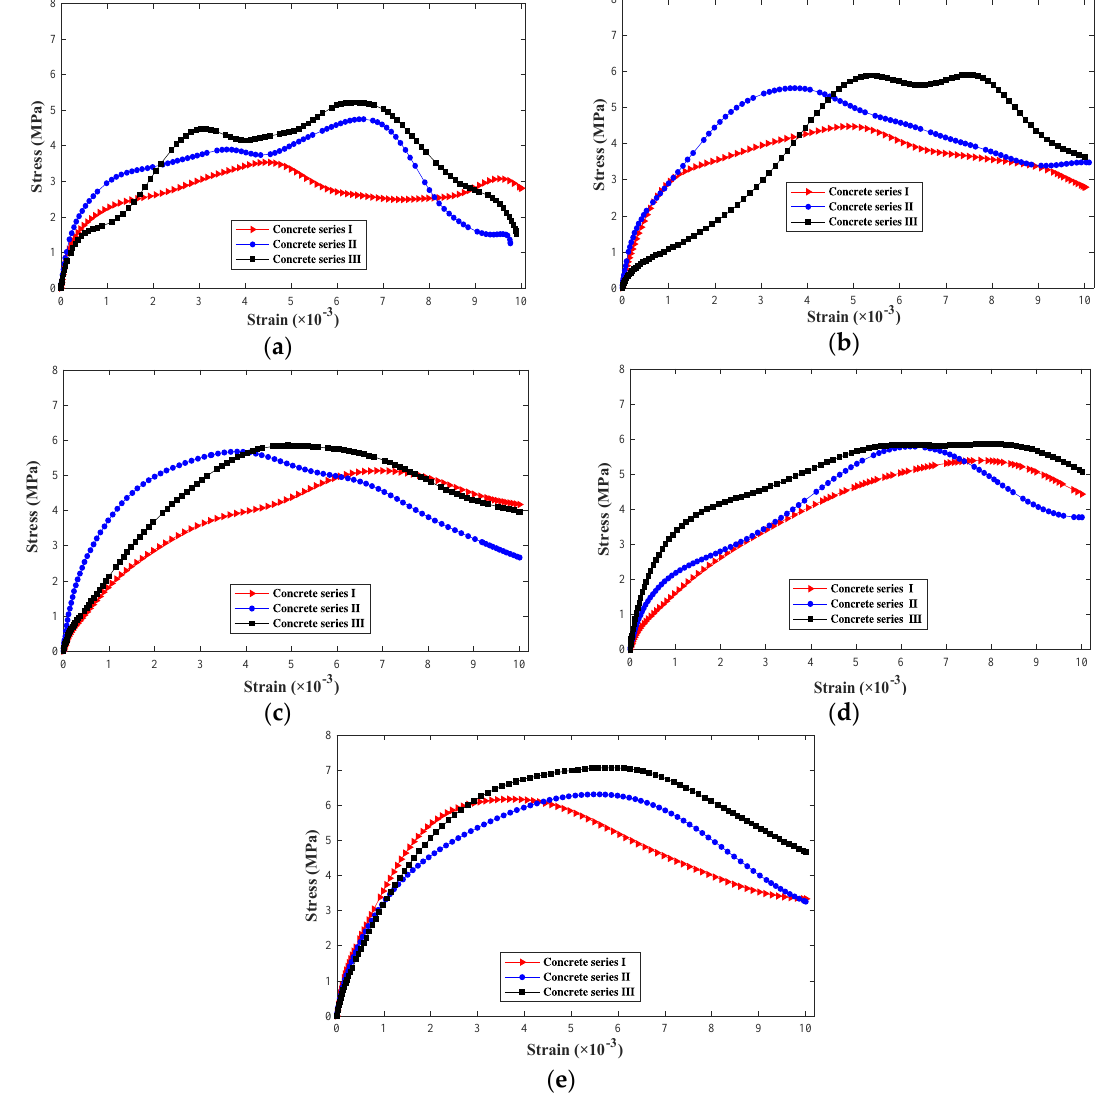
Figure 7. Dynamic stress-strain curves under di ff erent impact velocities: ( a ) 5.88 m / s; ( b ) 7.38 m / s; ( c ) 9.26 m / s; ( d ) 10.46 m / s; ( e ) 11.37 m /